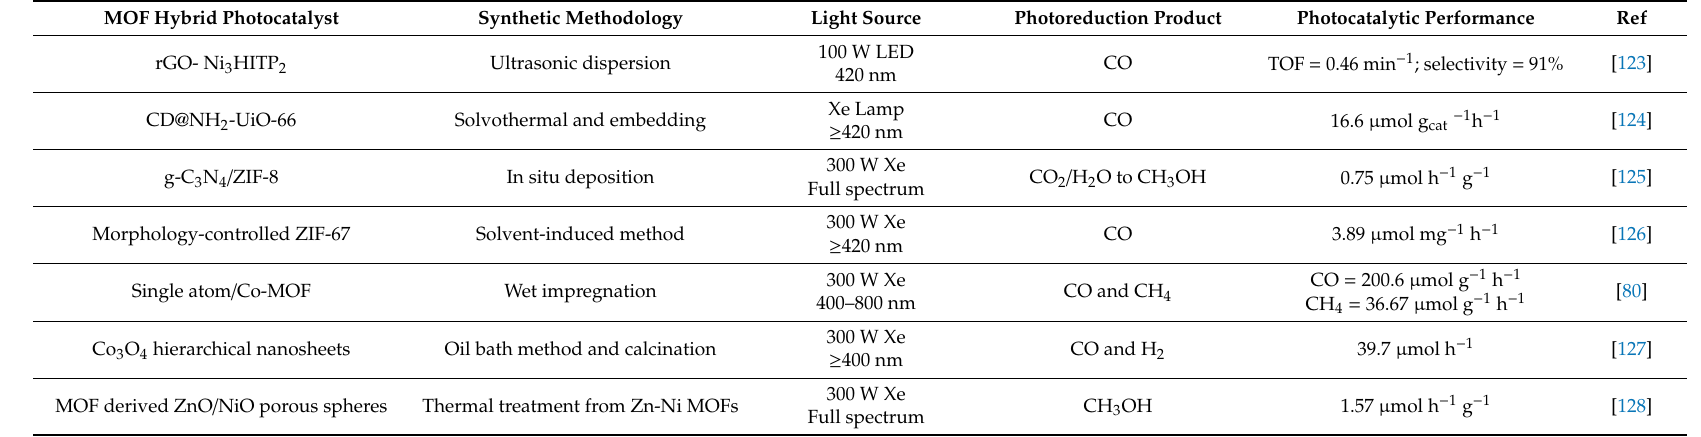
Table 6. Miscellaneous species incorporated within MOFs for photocatalytic CO 2